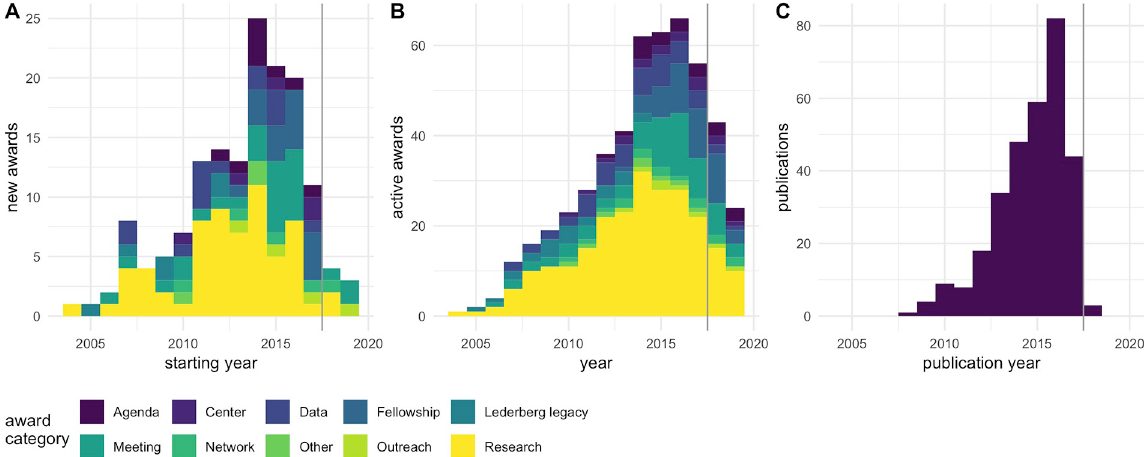
Fig 1. Awards and publications under the MoBE program. A: New awards made each year. B: Active awards in each year. C: Publications in each year. Dark gray vertical lines indicate the end of 2017, when MoBE-funded publications were identified. Colors indicate award types in A and B; color is not meaningful in